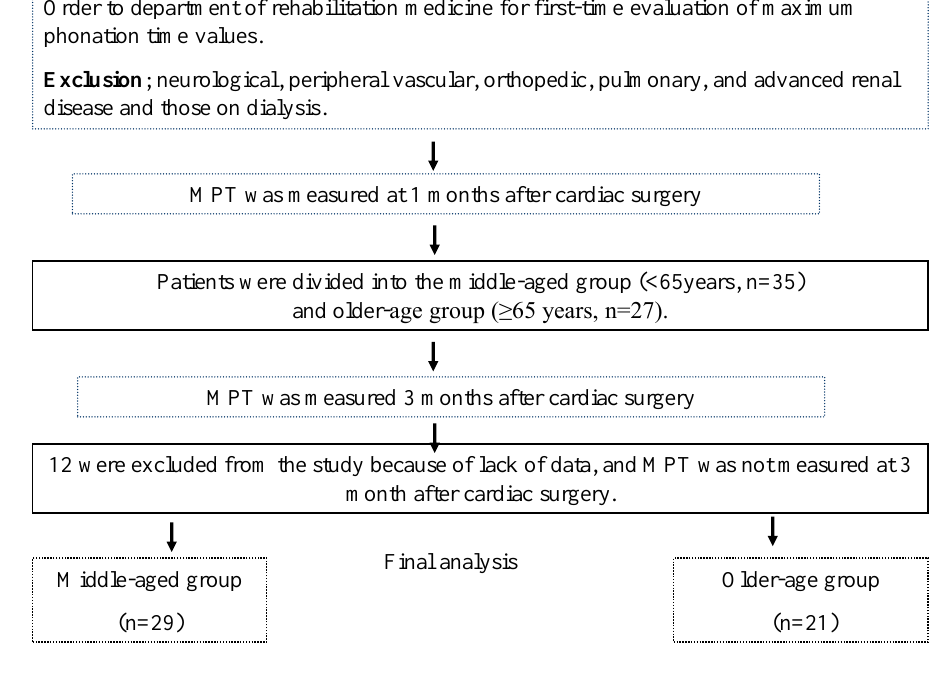
Figure 1. Diagram of the patient selection